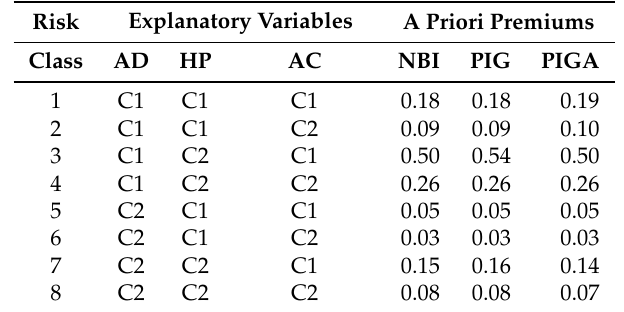
Table 5. A Priori premiums, regression models with varying